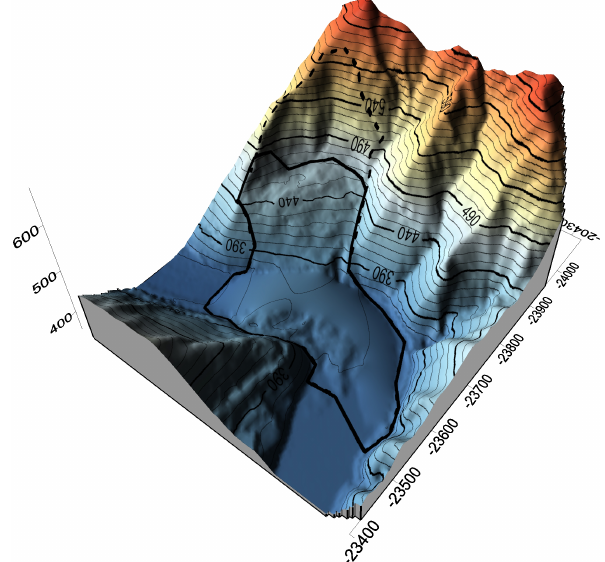
Figure 12. View of the final result of the deposit reconstruction; the black line indicates the contour used to compute the volume, and the red line indicates the upper scar.